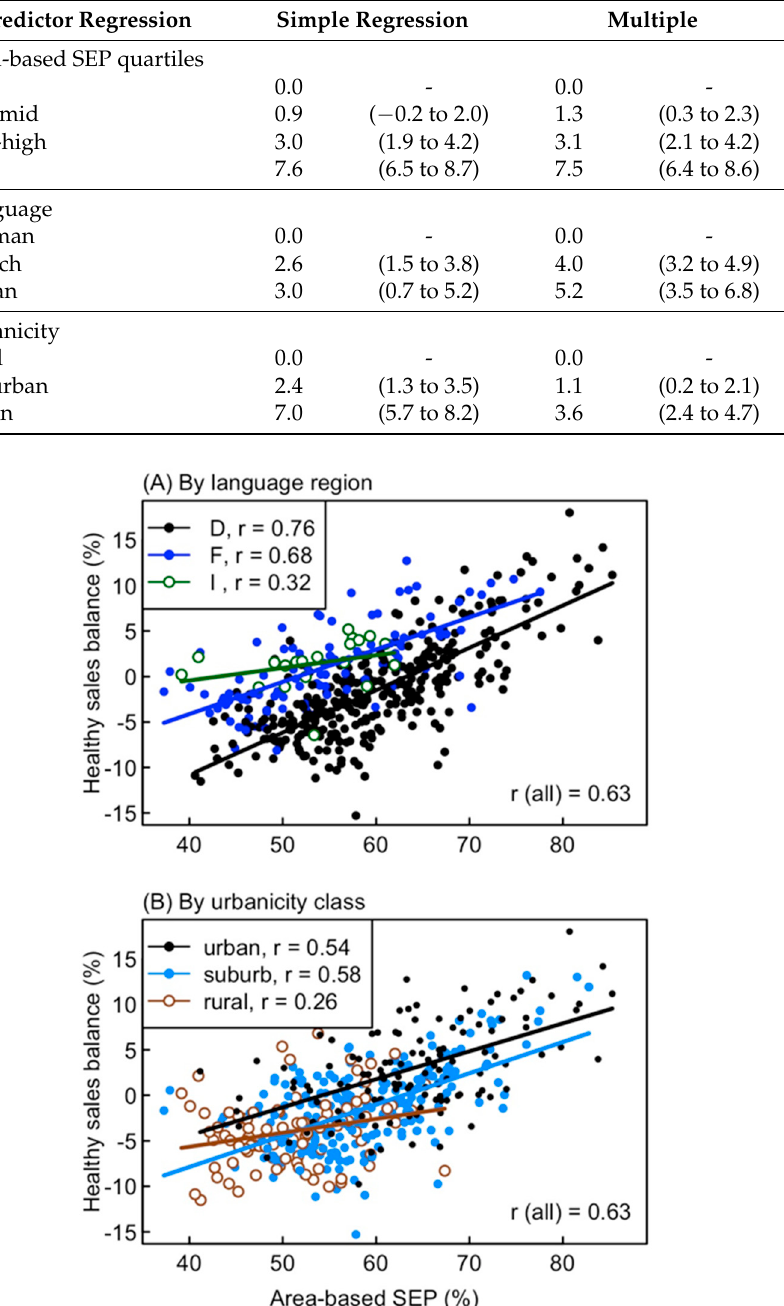
Table 4. Coefficients from regression models for the effects of area-based SEP (socioeconomic position, categorized into quartiles), language region and urbanicity on the healthy sales balance (difference between healthy and unhealthy sales as % of total food sales) with 95% CI. Simple regression means that separate models were fitted for each predictor, while the multiple regression included all predictors in one model. Each predictor’s reference category is included in the table with a coefficient of 0 for clarity.